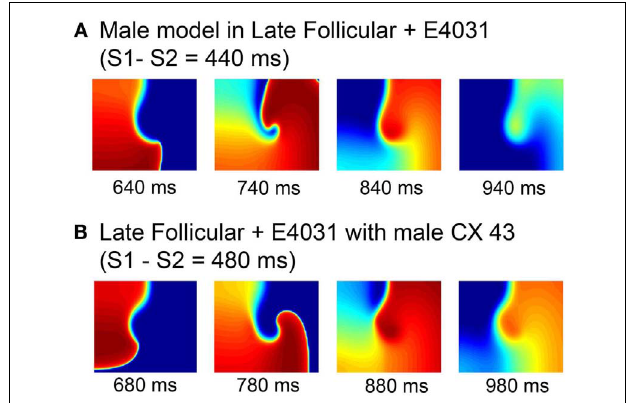
FIGURE 8 |Attempted induction of reentry in male heterogeneous tissues with female hormones and I Kr block during the late follicular phase (A) and female heterogeneous tissues in the late follicular phase and E-4031 10nM with measured male connexin 43 level (B). Four snapshots following application of hormones and/or drug at indicated time points.The protocol was as in Figure 5 . Table S2 | Effects of estradiol on I Kr .